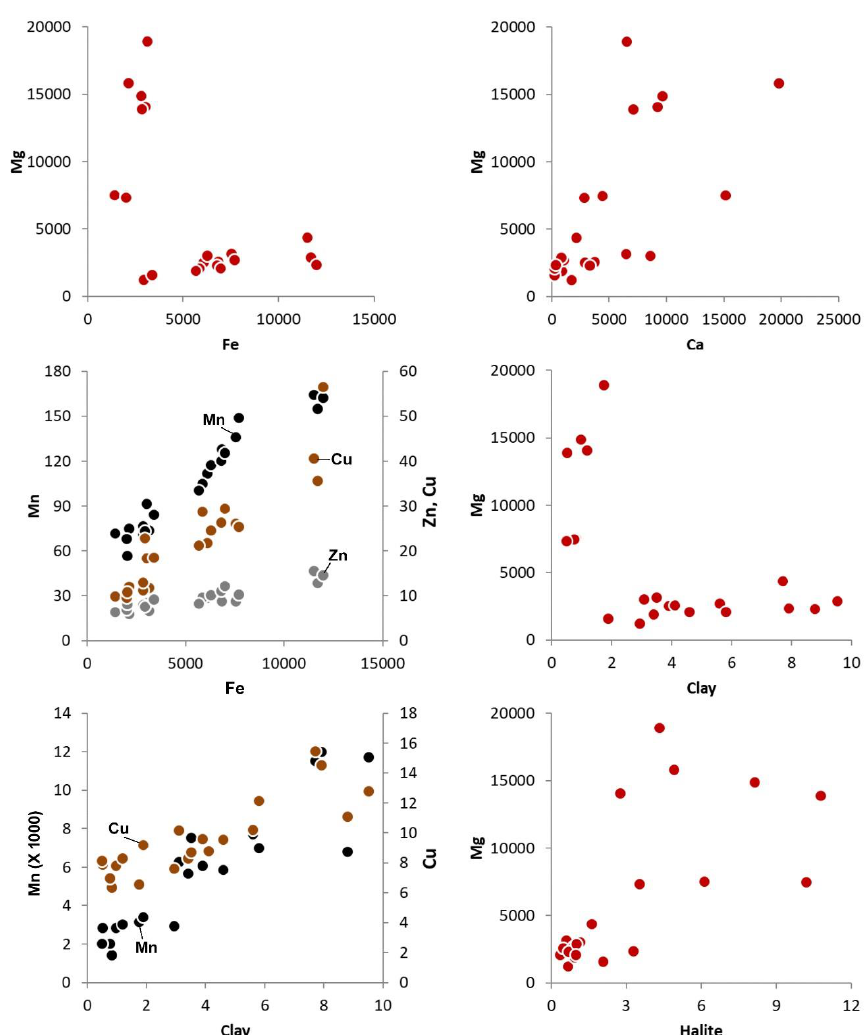
Figure 4. Ratios between chemical element concentrations and mineralogical and textural features of the sampled sediments. The plots Fe vs. Mg and clay (%) vs. Mg show two groups of samples, both displaying trends for increasing Mg with Fe and clay. Although with high scattering, Mg appears to correlate with Ca and halite. Samples enriched in clay also tend to yield higher Cu, Mn, Zn, and Fe.